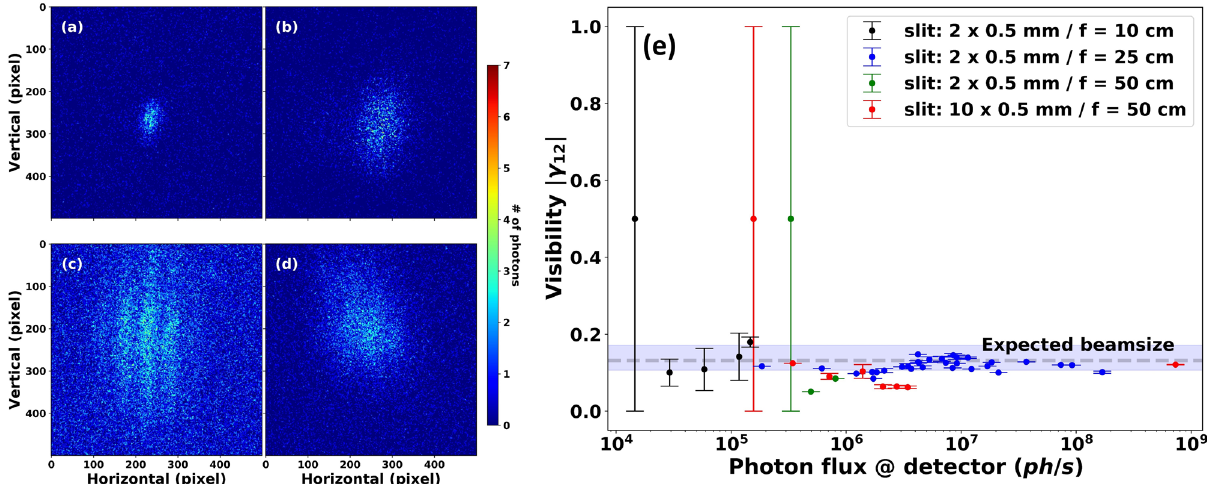
Fig. 5 Experimental results with various focal lengths and slit openings. Interferometry images are measured at minimum measurable intensity using a focusing lens with a focal length f of a 10 cm (2.9 × 10 4 photons), b 25 cm (1.8 × 10 5 photons), and c 50 cm (8.1 × 10 5 photons) with slit opening of 2 mm (horizontally)× 0.5 mm (vertically) and d a focal length of 50 cm with slit opening of 10 mm (horizontally)× 0.5 mm (vertically) (3.4 × 10 5 photons). (cid:5) (cid:5) (cid:5) (cid:5) ) at various intensities. The gray line represents the beam size measured by a director source size e Results of the measured absolute visibility ( γ 12 monitor. The error bar of each data point represents a statistical error estimated by analyzing multiple image samples and one standard deviation from the mean. Taking into account a quantum ef fi ciency of the camera of about 75 % at 750 nm wavelength, the photon fl ux at the lowermost intensity is about 2.3 × 10 4 photons per second